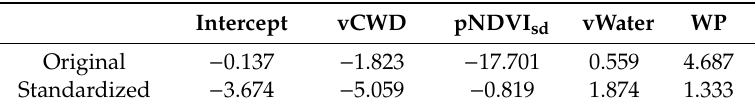
Table 4. Intercept and coe ffi cients for binomial part of the best zero-adjusted gamma model. Values are presented for models created with the original training data and models using standardized predictor variables (mean of zero and standard deviation of one). Variables include visible coarse woody debris area (vCWD), standard deviation of passive normalized di ff erence vegetation index (pNDVI sd ), visible water (vWater) and wetland probability (WP).